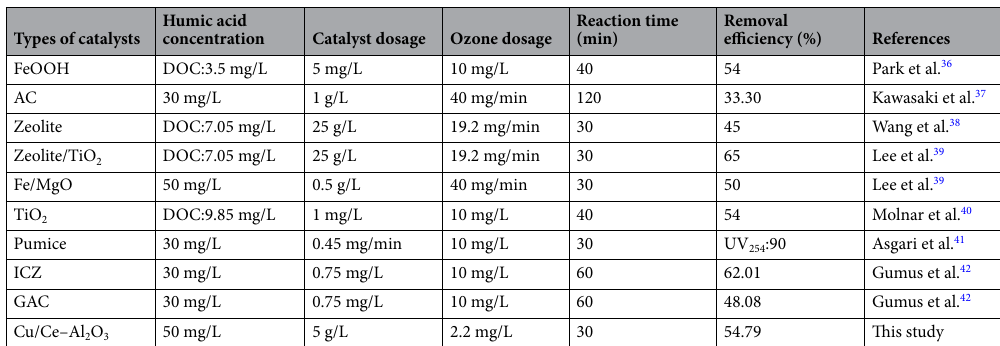
Table 2. Comparison of DOC removal efficiencies of catalytic ozonation